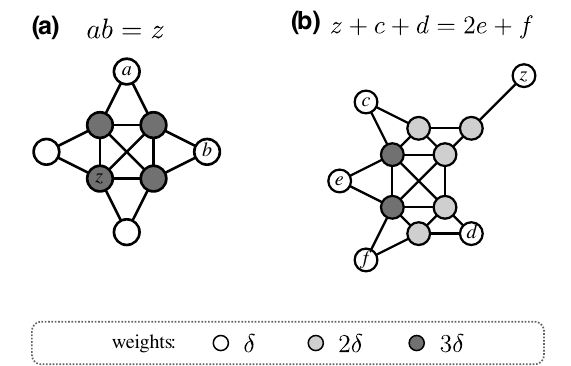
FIG. 12. The two basic components of the factoring gadget. The gadget in (a) is a crossing gadget. Besides its use in routing effective variables a and b , it also serves as a tool to access the value of the product of the variables, z = ab , at the indicated interior vertex. The gadget in (b) is the MWIS representation of the constraint z + c + d = 2 e + f